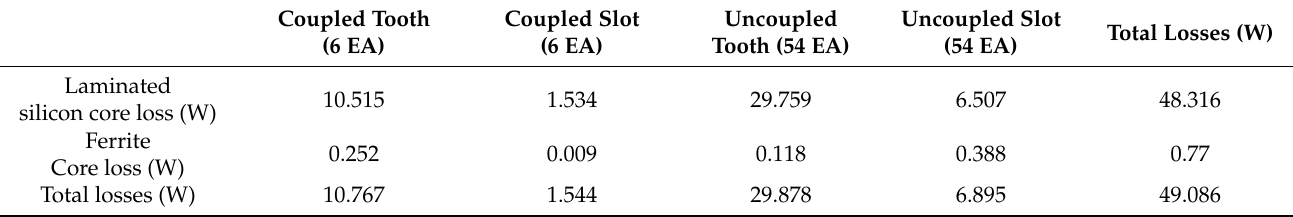
Table 3. Core losses without load.